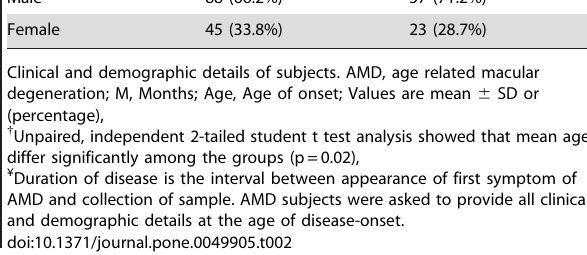
and demographic details at the age of disease-onset.